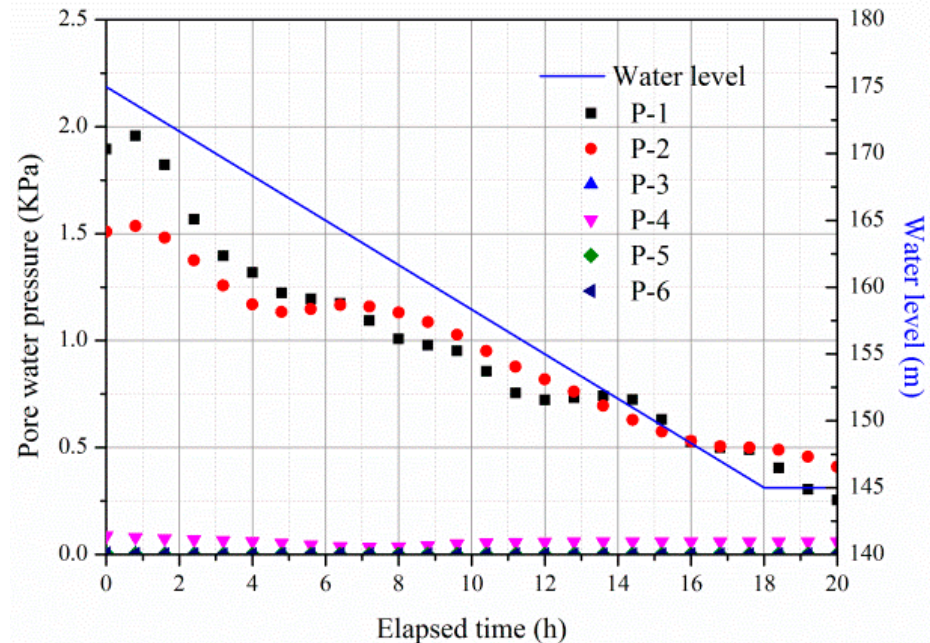
Figure 10. Pore water pressure levels during the water level lowering process.